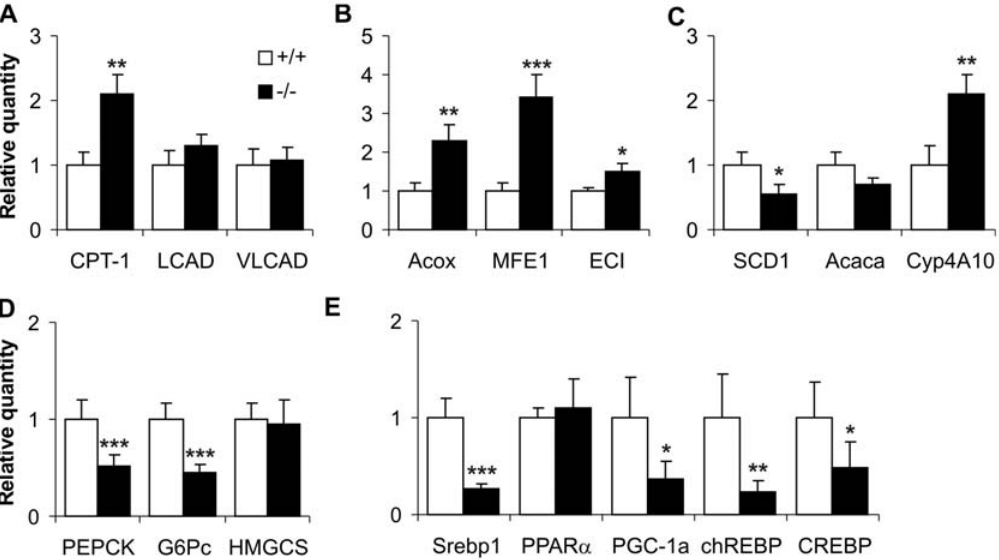
Figure 8. Effect of fasting on hepatic expression levels of genes for mitochondrial and extramitochondrial fatty acid metabolism. Quantitative real-time PCR analysis was used to determine changes in hepatic gene expression in Decr 2 / 2 mice (solid bars) after 24 h of dietary stress compared with wild type mice (open bars). (A) Relative expression levels of genes involved in mitochondrial b -oxidation; CPT-1, LCAD, and VLCAD. (B) Relative expression levels of genes involved in the peroxisomal b -oxidation pathway; Acox, MFE1 and ECI. (C) Relative expression levels of genes involved in fatty acid synthesis, desaturation and microsomal v -oxidation; Acaca, SCD1 and Cyp4A10, respectively. (D) Relative expression levels of genes involved in the gluconeogenetic pathway and ketone body synthesis; PEPCK, G-6Pase and HMGCS, respectively. (E) Relative expression levels of genes encoding transcriptional factors; PPAR a , Srebp1, chREBP, CREB, and the co-activator PGC-1 a . For relative quantification of gene expression, the results were normalized using GAPDH as an endogenous control for each sample, and the data obtained for wild type samples were set to 1. Results represent means 6 SE of 5 mice of each genotype per group. Statistically significant differences in expression levels between wild type and Decr 2 / 2 mice are indicated by asterisks (* p , 0.05, ** p , 0.01, *** p ,